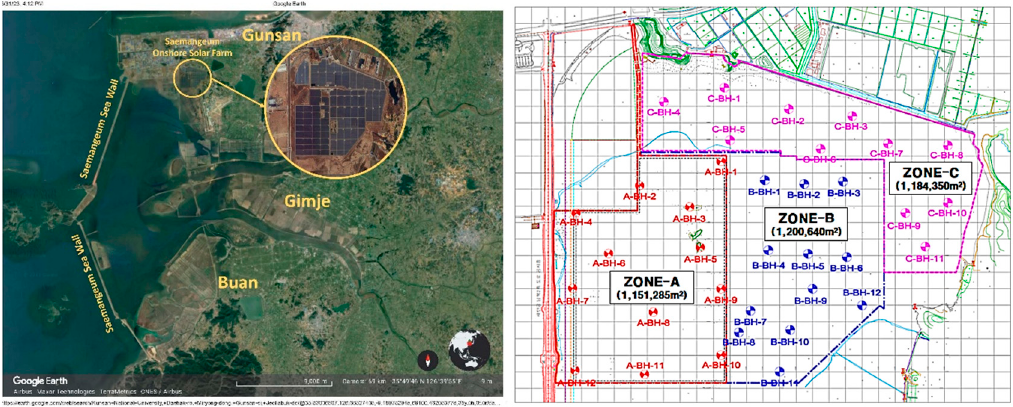
Figure 2. Study area, Saemangeum onshore solar farm, Gunsan, Republic of Korea.